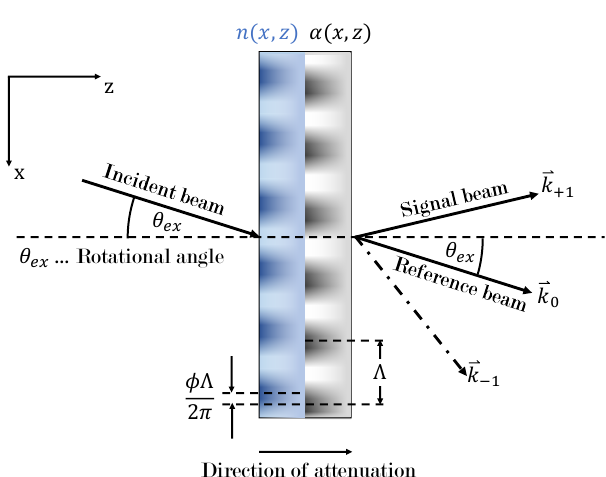
Figure 2. The gratings are assumed to consist of a phase and amplitude grating with mutually-shifted modulation. The modulation amplitudes n 1 ( z ) and α 1 ( z ) are attenuated along the z-direction. In the experimental setup, the rotational angle of the sample corresponds to the external angle of